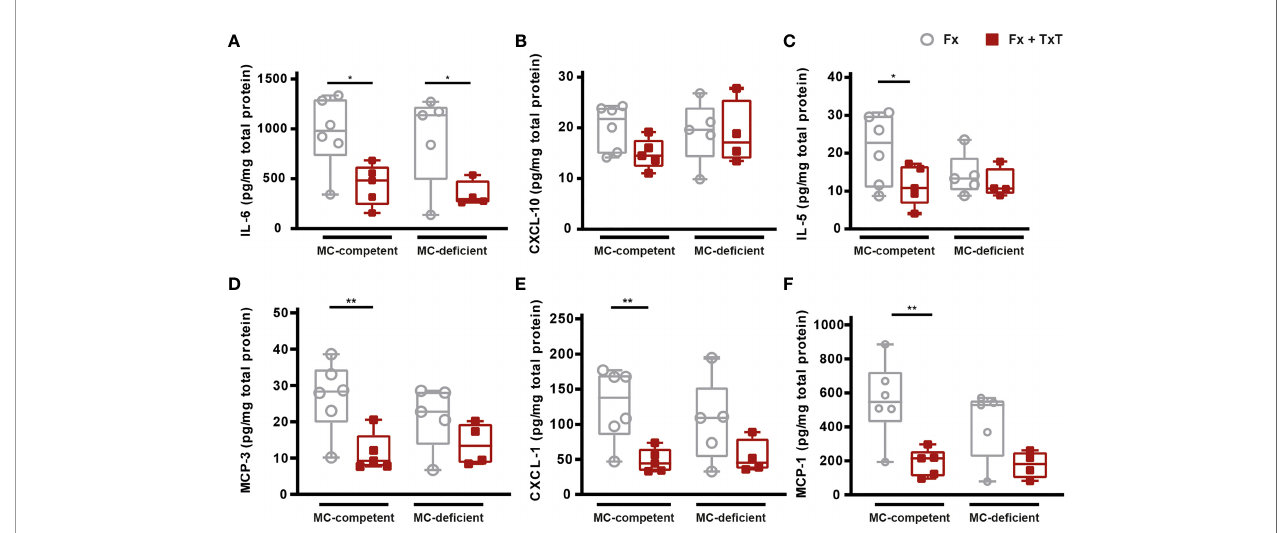
FIGURE 5 | Local in fl ammation in the fracture hematoma of mast cell (MC)-competent and MC-de fi cient mice 3 h after isolated fracture (Fx) and combined fracture and thoracic trauma (Fx + TxT). Hematoma (A) interleukin-6 (IL-6), (B) C-X-C motif chemokine ligand 10 (CXCL-10), (C) IL-5, (D) monocyte chemoattractant protein- 3 (MCP-3), (E) CXCL-1, and (F) MCP-1 levels. Gray boxes represent Fx mice, red boxes represent Fx + TxT mice. Data are shown as box-and-whisker plots (with median and interquartile range) from maximum to minimum, showing all data points. *p<0.05; **p<0.01. The p values were determined using one-way ANOVA with post hoc Fisher ’ s LSD in the case of normal distribution or with Kruskal-Wallis with post hoc Dunn ’ s test if data were not normally